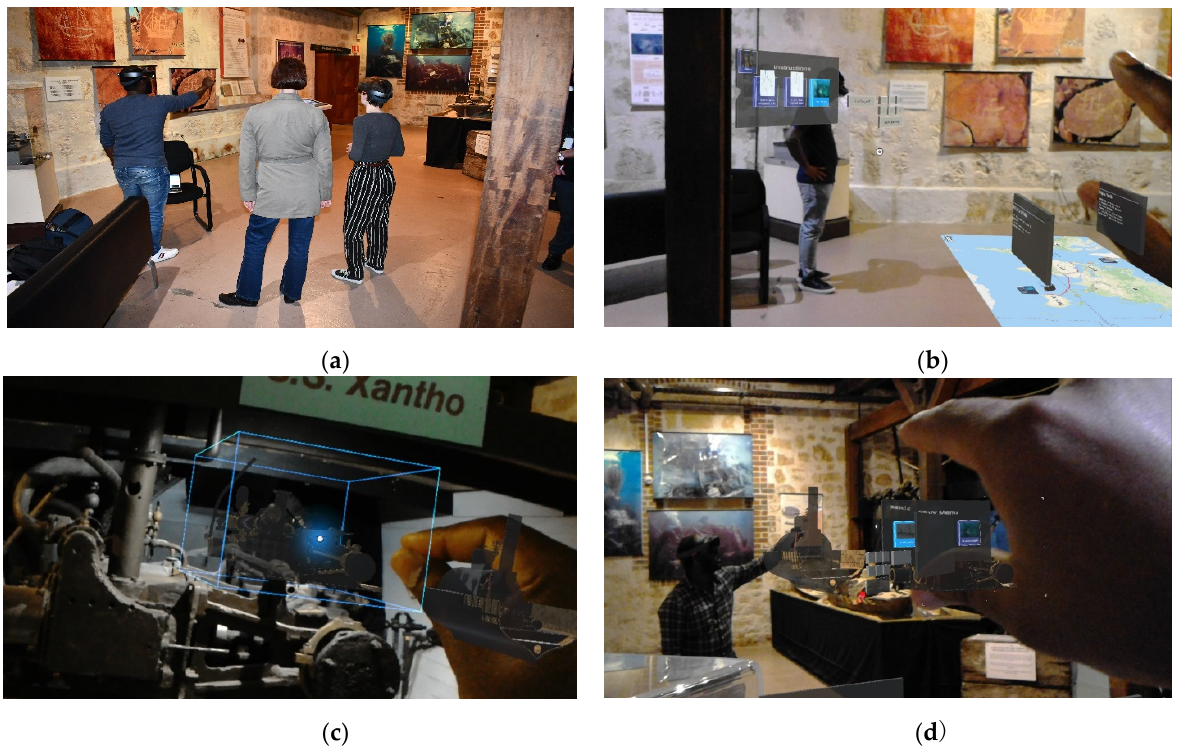
Figure 3. Users interacting with the clouds-based collaborative and multi-modal mixed reality application. ( a ) A total of two users interact with the collaborative and multi-modal mixed reality application at Western Australia Shipwreck Museum. ( b ) A total of two users collaboratively interact and explore the Walkable Mixed Reality Map. ( c ) User interacting with 3D model. ( d ) A total of two users interacting with 3D models.